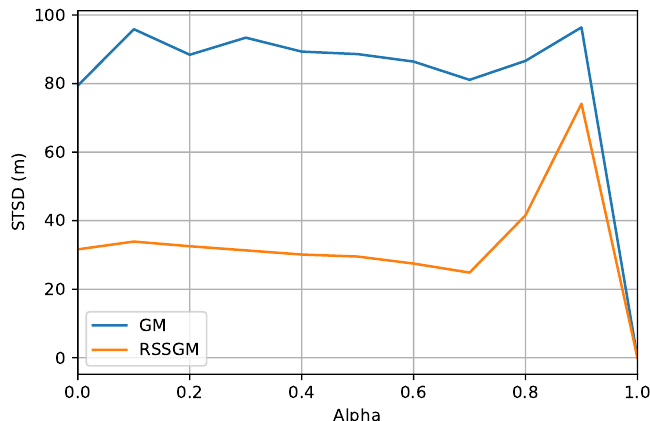
Figure 6. Impact of α on spatial and temporal standard deviation